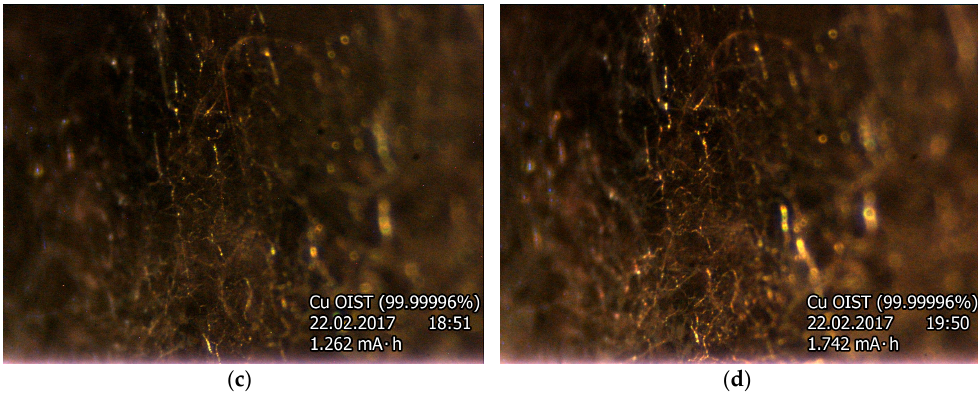
Figure 5. Images of the surface of 99.99996% coarse copper irradiation by a 2-MeV proton beam with varying integrals of the current: ( a ) 0.201; ( b ) 0.905; ( c ) 1.262; ( d ) 1.742 mA·h. The frame size is 9 mm horizontally and 4 mm vertically.